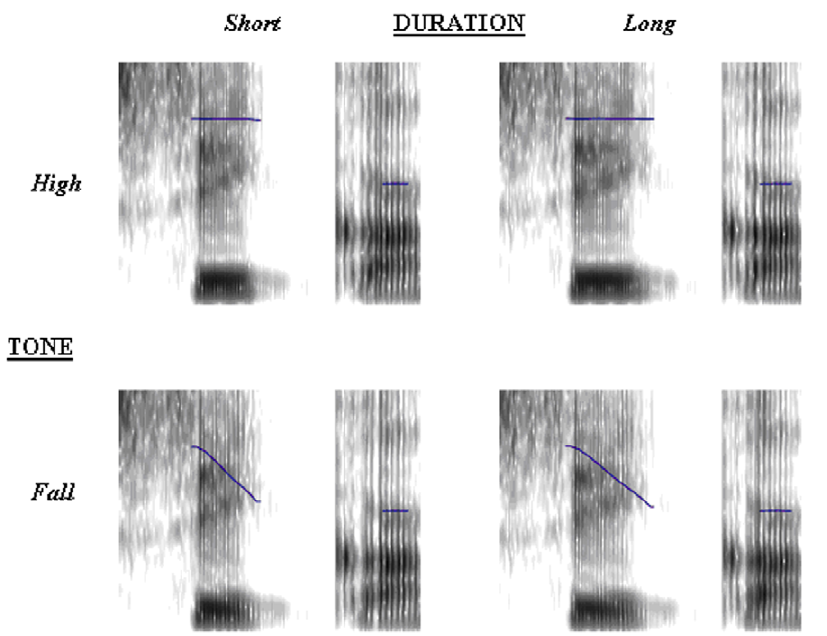
Figure 6. Example of actual materials from Experiment 2. Example of actual materials from Experiment 2 showing spectrograms and f0 contours for tone (high, fall) and duration (short, long) in the critical conditions. Corresponding audio files Audio S1-S4 can be found in the supporting materials.